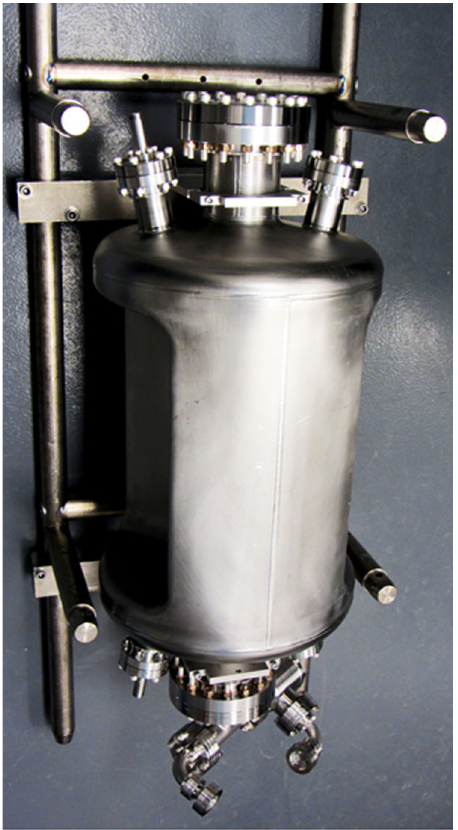
FIG. 8. Assembled cavity prior to test with fixed input coupler at the bottom and pickup probe at the